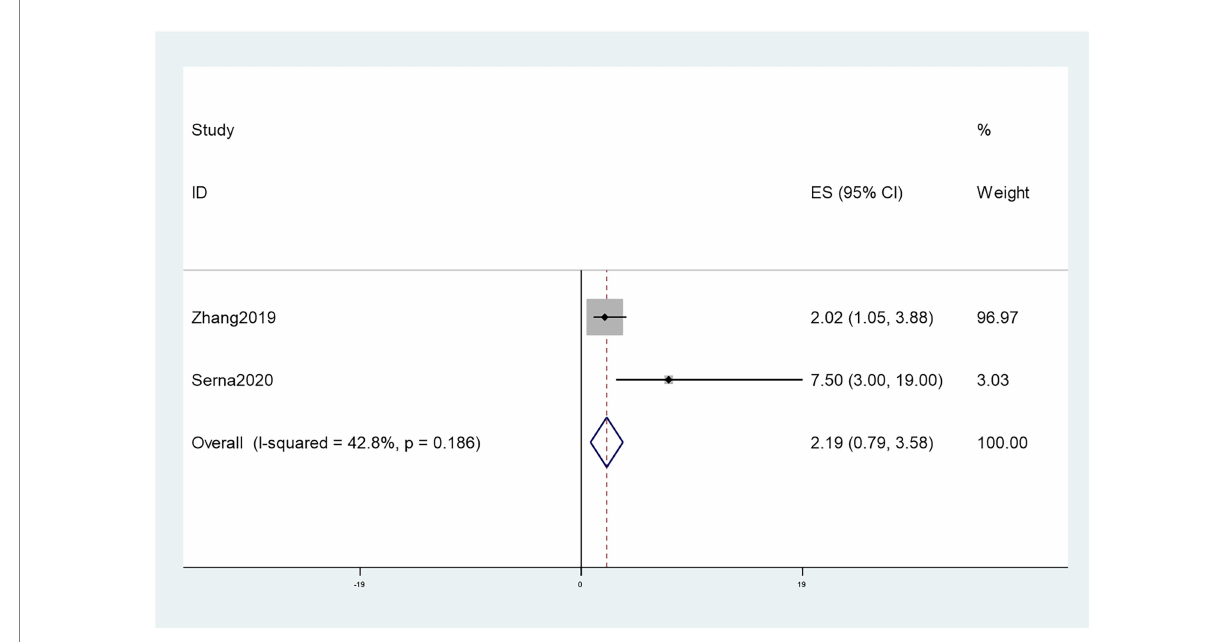
FIGURE 11 Forest plot of the relationship between Fusobacterium nucleatum and RFS in cancer.